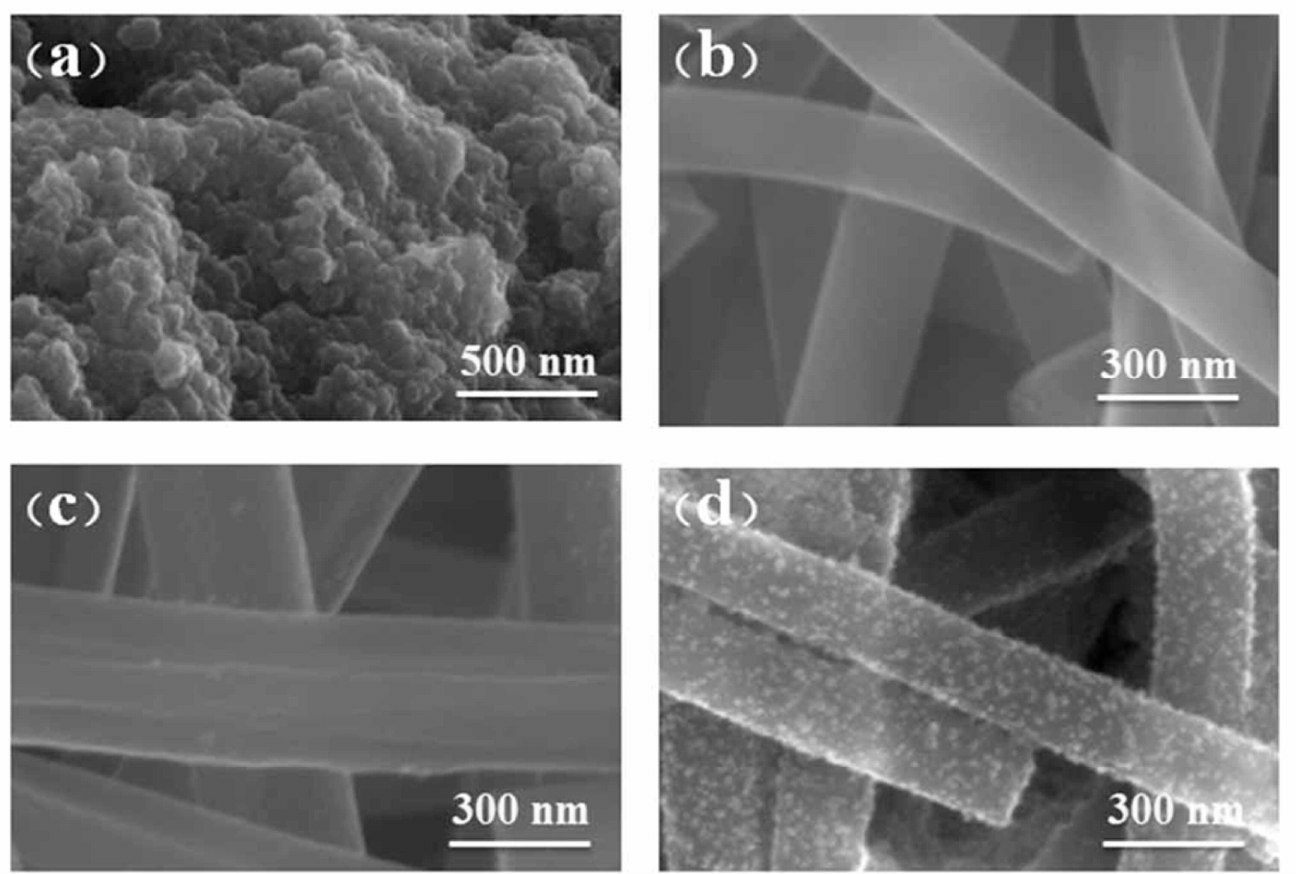
Figure 3. The SEM images of the surface topography of ( a ) Fe 3 O 4 powder at 500 nm and ( b ) CNFs, ( c ) Sn@CNFs, ( d ) Fe 3 O 4 -Sn@CNFs at 300 nm.